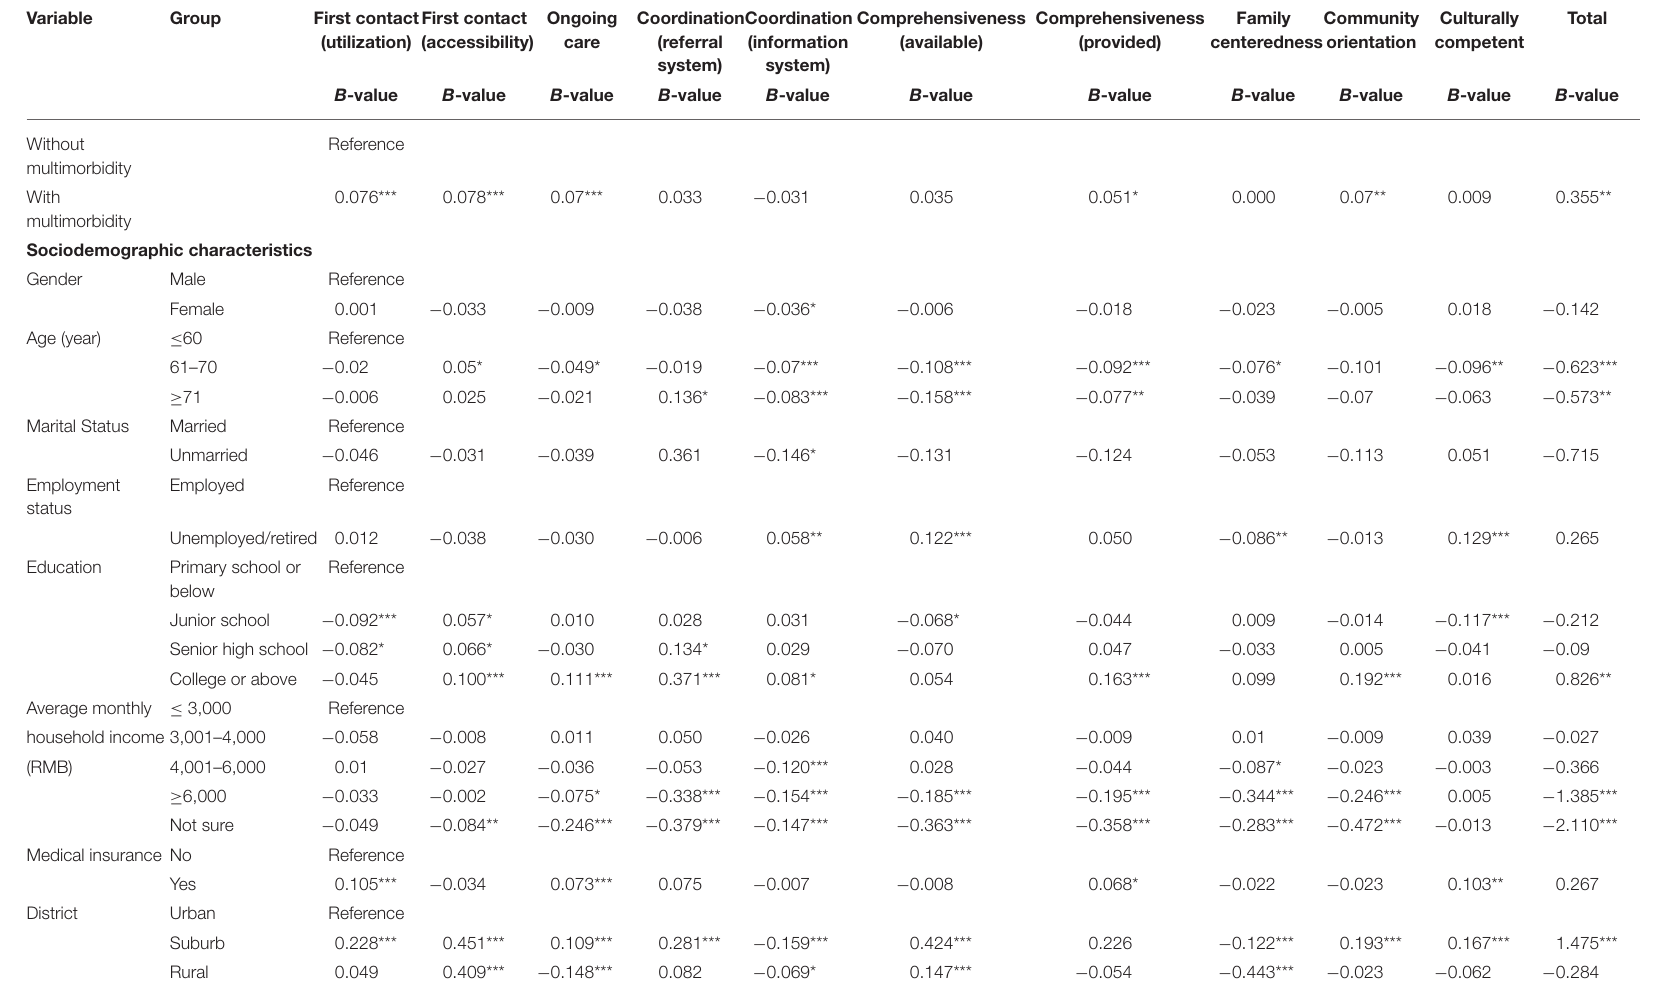
TABLE 3 | Multiple regressions of participants’characteristics associated with individual and total primary care attributes